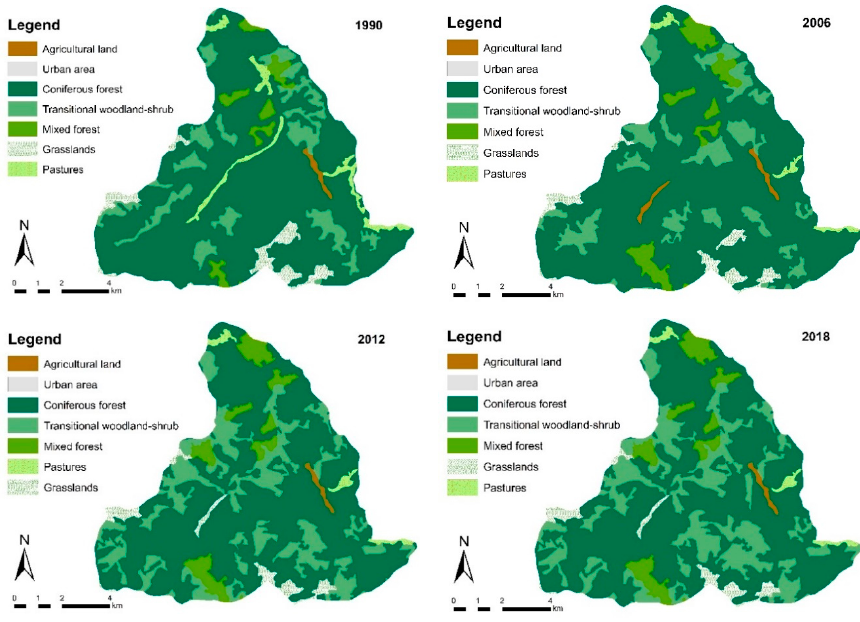
Figure 4. Ipoltica River basin—CORINE Land Cover 1990, 2006, 2012, and